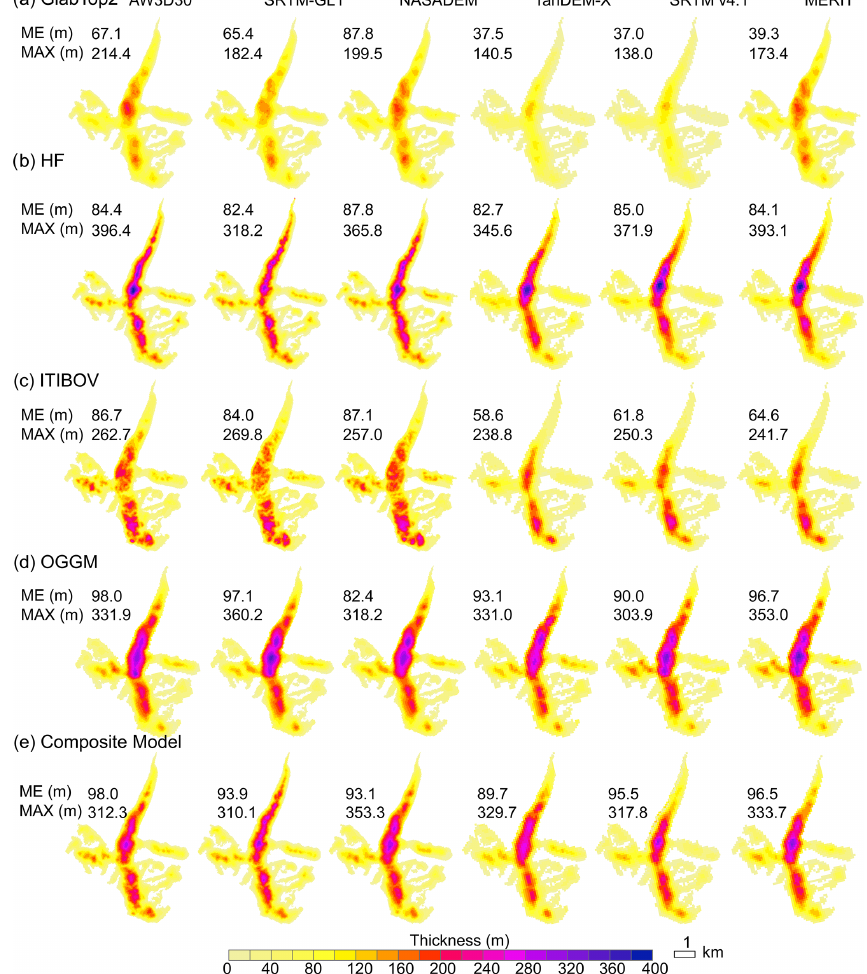
Figure 8. Distribution of modeled ice thickness of Chhota Shigri Glacier (location shown in Fig. 1) using AW3D30, SRTM-GL1, TanDEM- X, SRTM v4.1, NASADEM, and MERIT: (a) GlabTop2, (b) HF, (c) ITIBOV, (d) OGGM, and (e) composite result. Mean (ME) and maxi- mum (MAX) modeled ice thickness are given in each